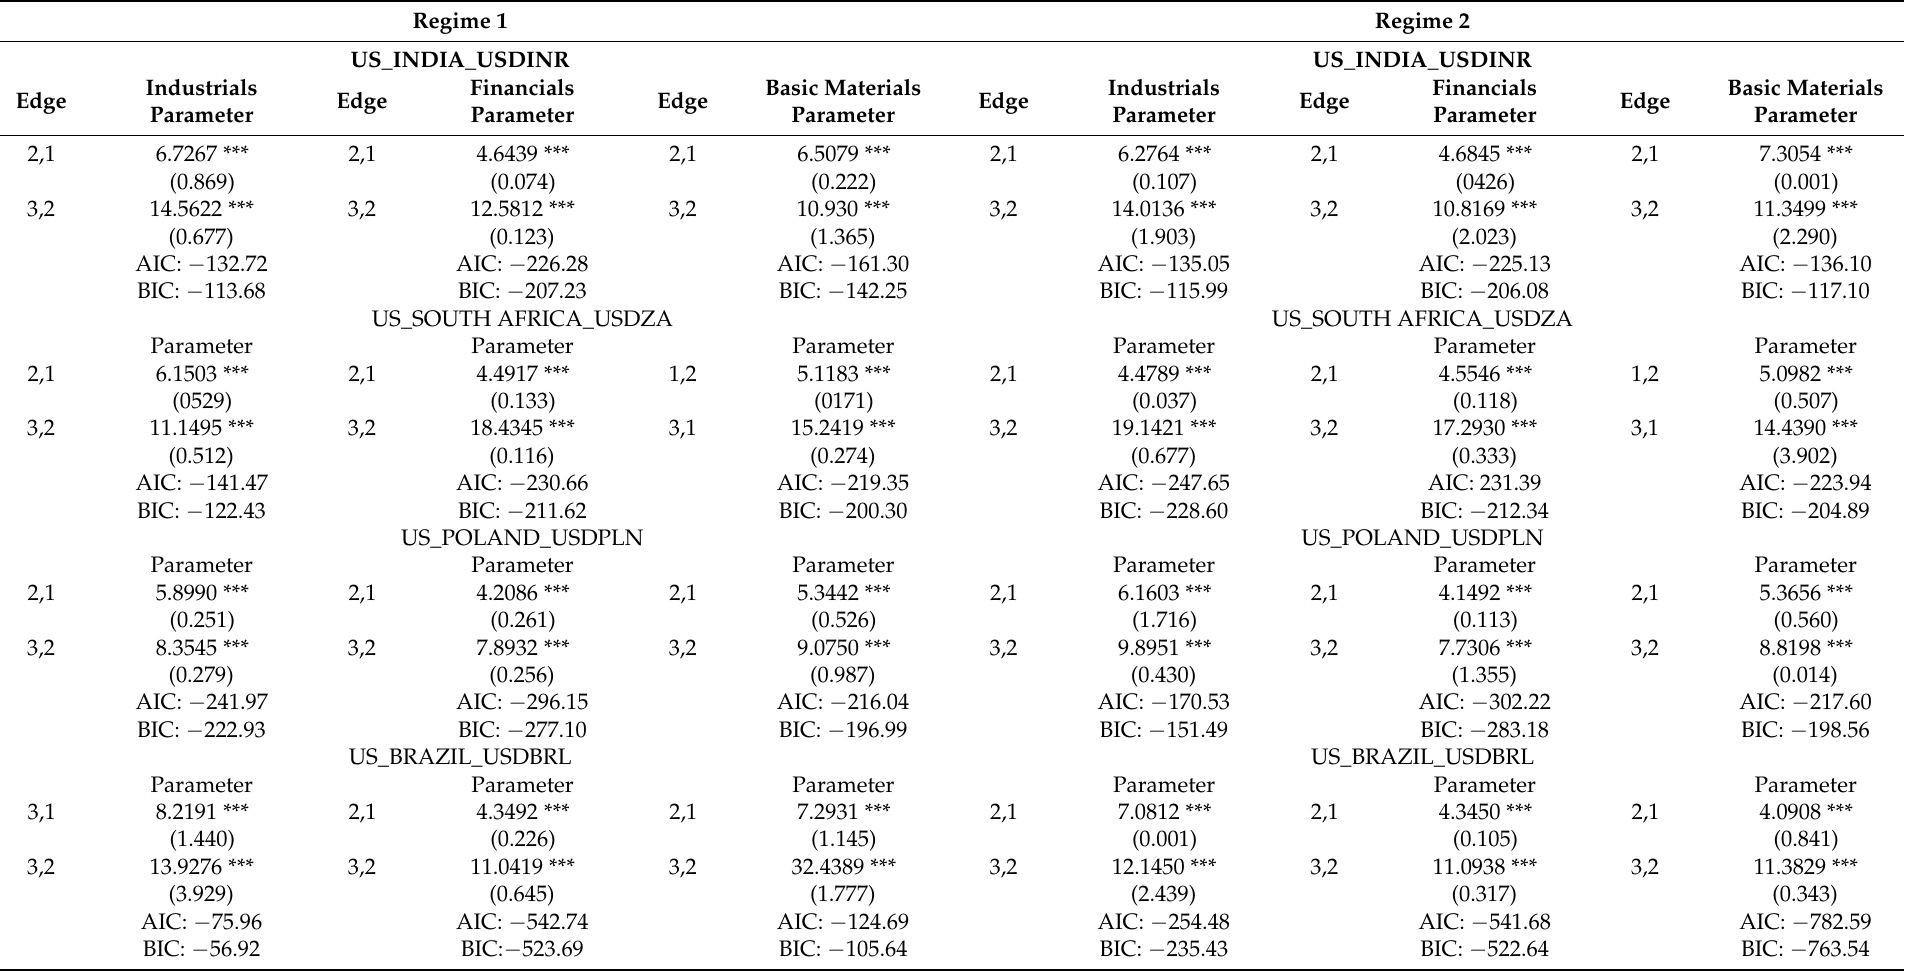
Table A2. Parameters for C-Vine copulas between US, sectorial equity markets of emerging economies and the US foreign exchange against domestic currencies. Regime 1 Regime